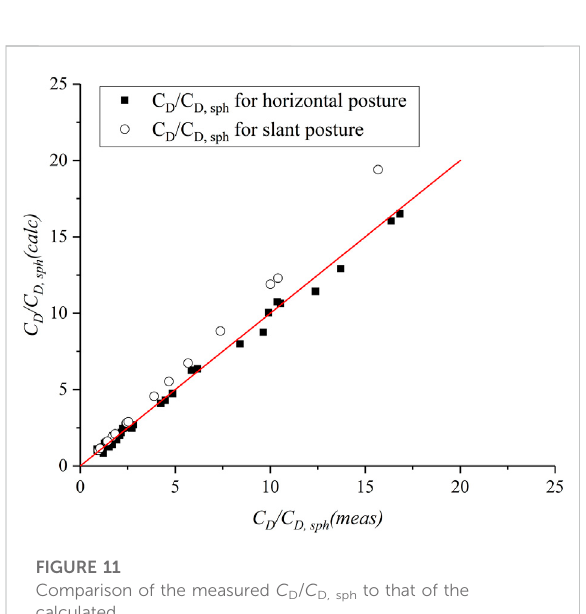
FIGURE 11 Comparison of the measured C D / C D, sph to that of the